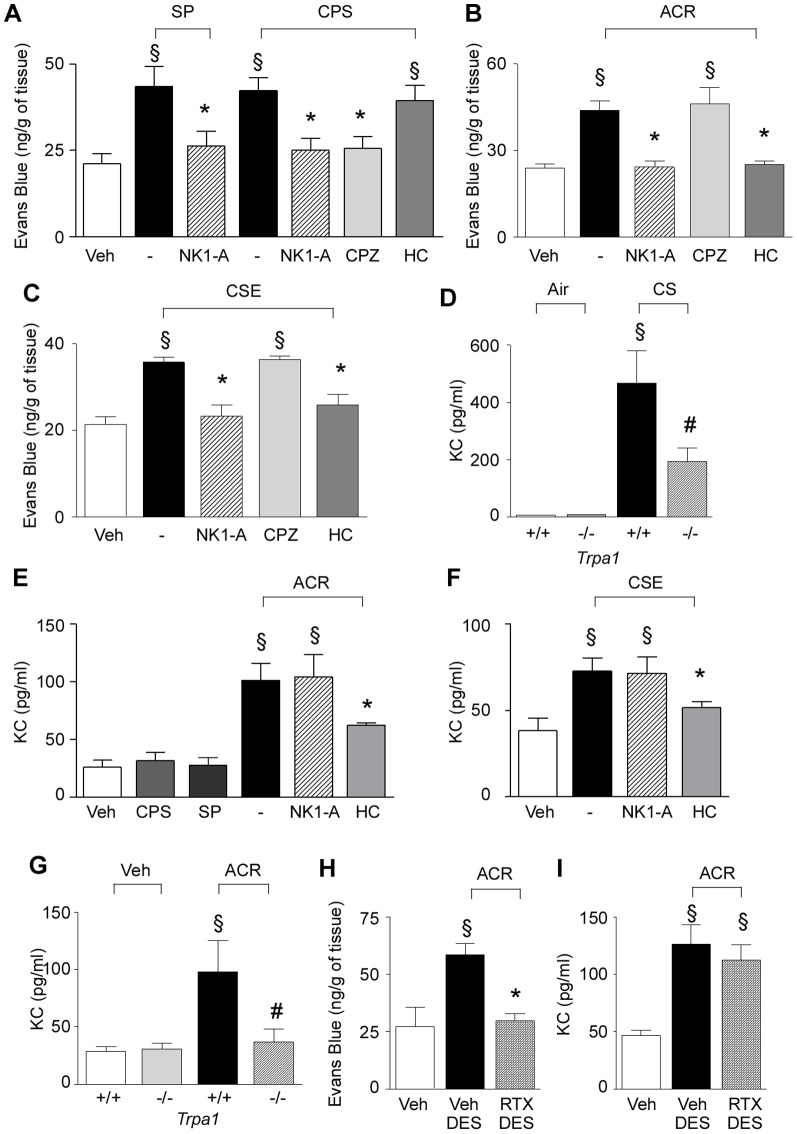

In vivo KC release via a non-neuronal TRPA1-dependent mechanism.(A) Intratracheal instillation (i.t., 30 µl) of substance P (SP, 25 nM), capsaicin (CPS, 100 µM) in C57BL/6 mice increases Evans blue dye extravasation (PPE) in trachea and bronchi an effect prevented by L-733,060 (NK1 receptor antagonist, NK1-A; 2 µmol/kg, i.v.) and capsazepine (CPZ; 30 mg/kg, i.p.) but not by HC-030031 (HC; 300 mg/kg, i.g.). (B) L-733,060 and HC, but not CPZ prevent acrolein (ACR, 5 mM, i.t.)- and (C) cigarette smoke extract (CSE, 1 OD, i.t.)-evoked increase in PPE in C57BL/6 mouse trachea and bronchi. Each column represents mean ± SEM of at least 5 mice. Veh is the vehicle of the various agonists. §
P<0.05 vs. Veh; *
P<0.05 vs. treated group. (D) Cigarette smoke (CS)-evoked increase in KC in BAL from Trpa1+/+ is reduced in Trpa1−/− mice. Each column represents mean ± SEM. §
P<0.05 vs. air-exposed Trpa1+/+ mice. #
P<0.05 vs. Trpa1+/+ CS group. (E) ACR (5 mM, i.t.), but not CPS (100 µM, i.t.) or SP (25 nM, i.t.) increases KC release in BAL. HC, but not L-733,060, reduces the increase in KC release by ACR (E) or CSE instillation (1 OD, i.t.) (F). (G) ACR (5 mM, i.t.)-evoked increase in KC in BAL is practically absent in BAL of Trpa1−/− mice. Resiniferatoxin-desensitization (RTX-DES) abolished PPE-induced by ACR (5 mM, i.t.) (H), while did not modify the ACR-evoked KC release (I). Veh-DES is the vehicle of RTX. Each column represents mean ± SEM of at least 5 mice. §
P<0.05 vs. Veh or Veh-Trpa1
+/+; *
P<0.05 vs. treated group; #
P<0.05 vs. ACR-Trpa1
+/+.